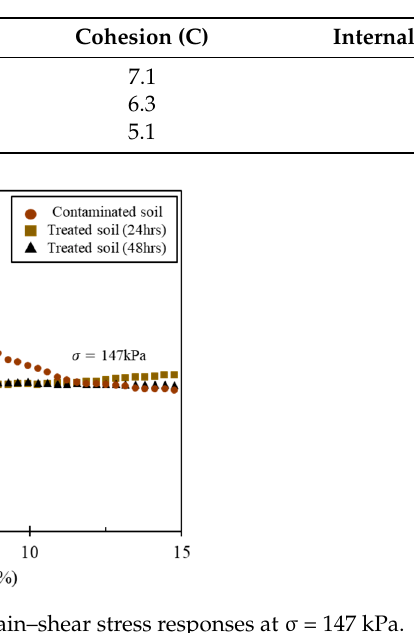
Table 4. Shear strength of tested soils.